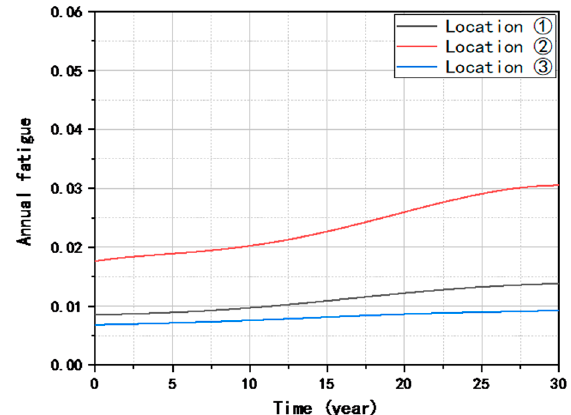
Figure 11. Accumulated fatigue damage of tubular joints under the combined loads obtained by the simple addition method.